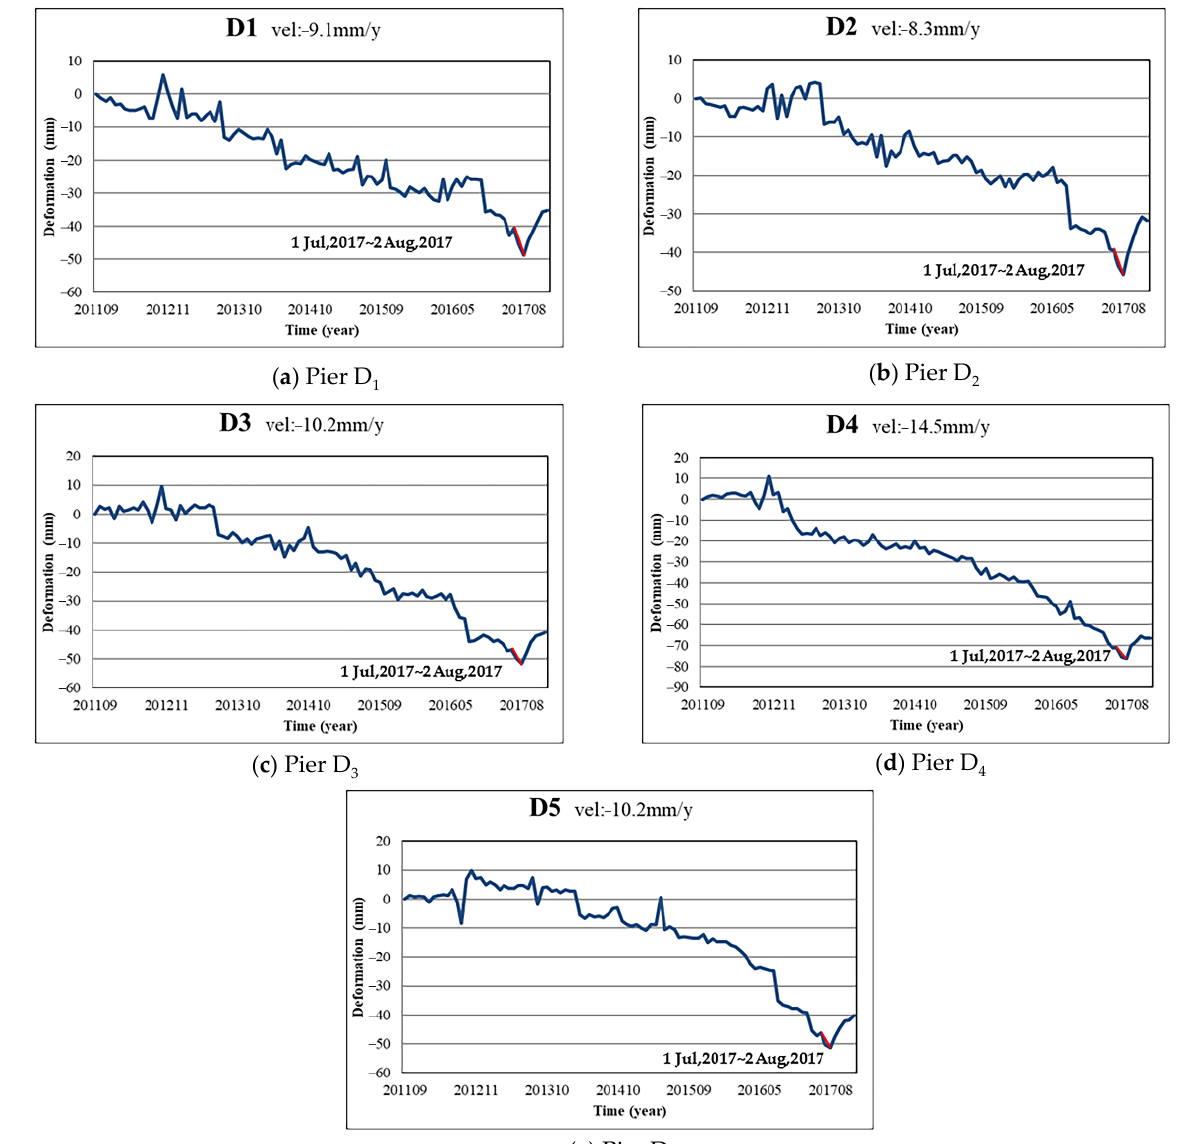
Figure 12. ( a – e ) represents deformation values of five Suzhou bridge piers. The 96 issued time-series deformation values of five piers were sorted into sequence working conditions, as shown in Table 4. The deformation value is shown in mm. Working condition 1 corresponds to the data of PS points on piers from the first issue. Since it is the first time that data has been obtained in this area, the deformation values of condition 1 were all set to